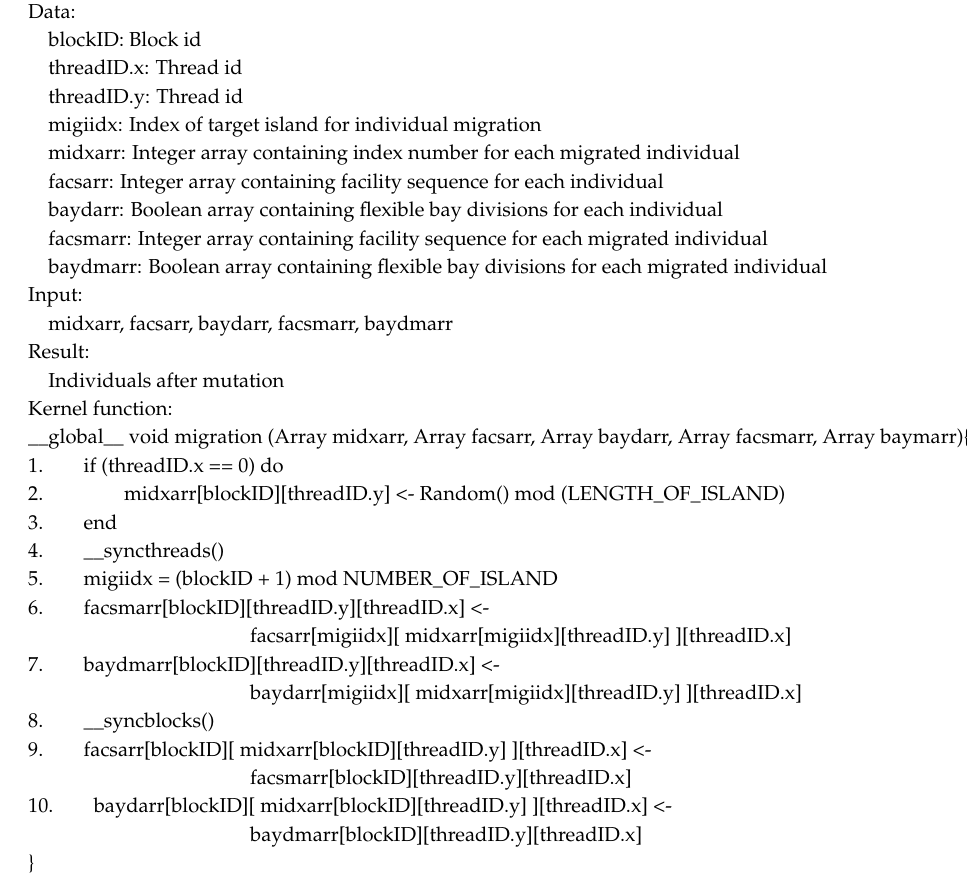
Algorithm 5: Parallel Migration Operator